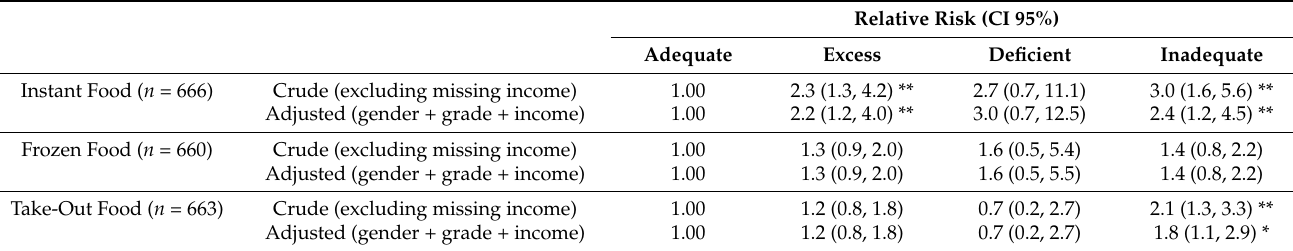
Table 5. Crude and multinomial regressions for non-adequate